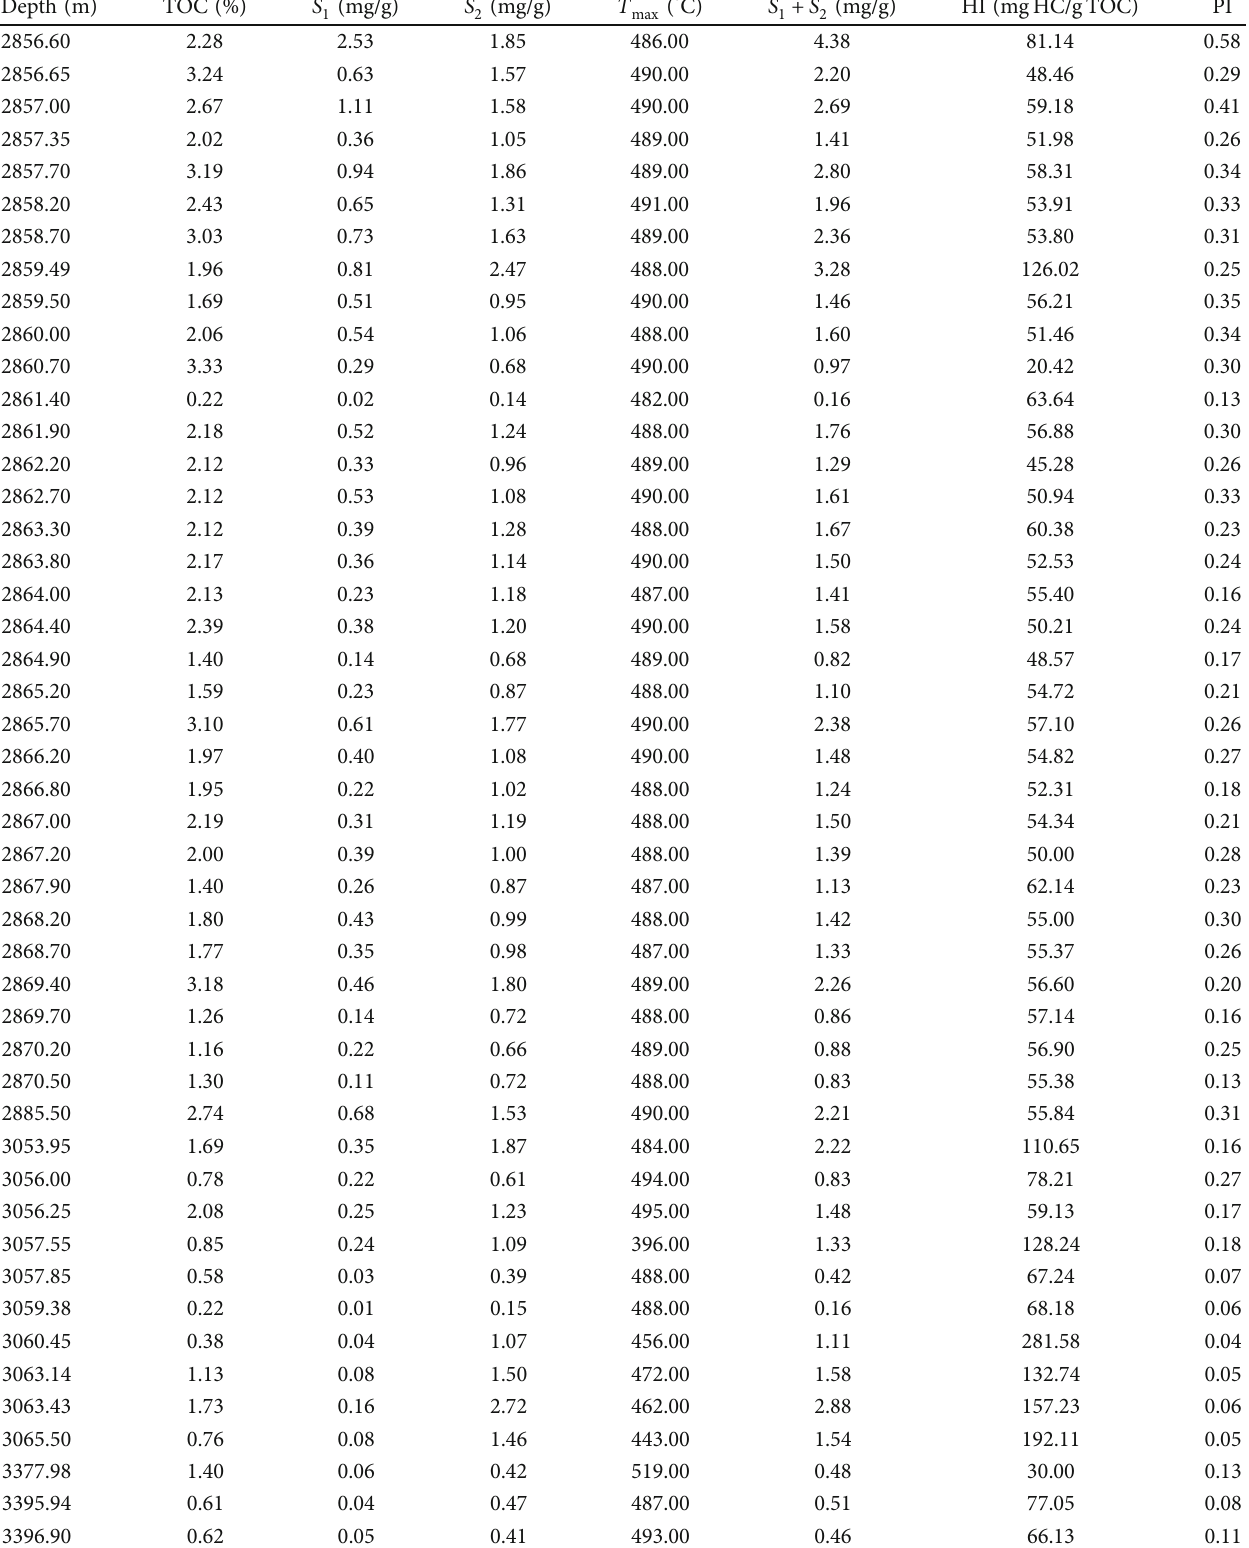
Table 1: Results of Rock-Eval